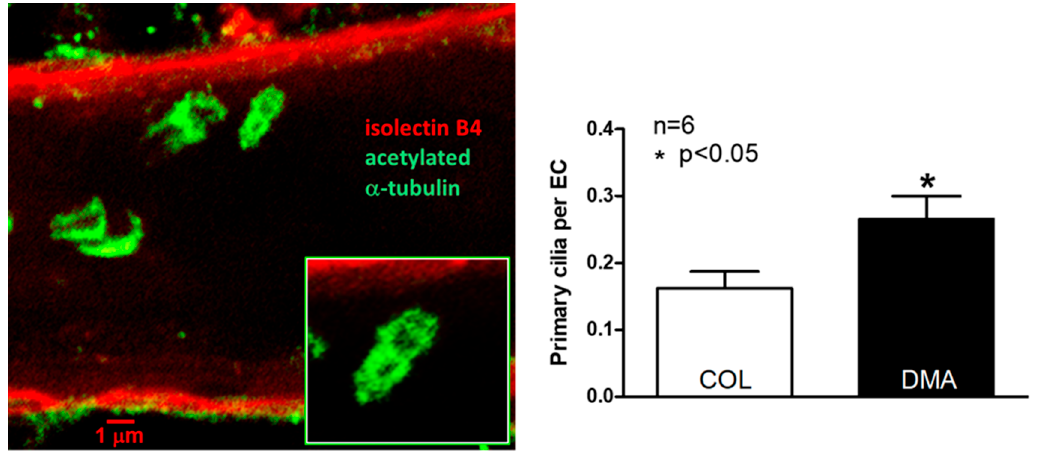
Figure 4. Collateral endothelial cells have fewer primary cilia than distal-most arterioles (DMA). Immunofluorescent-stained collaterals (COL) with focal plane set within the lumen above the far-wall, showing primary cilia. Figure S2 shows cilia on DMAs. Inset, higher magnification. Right panel, n = 6 mice, 2-sided t-test.